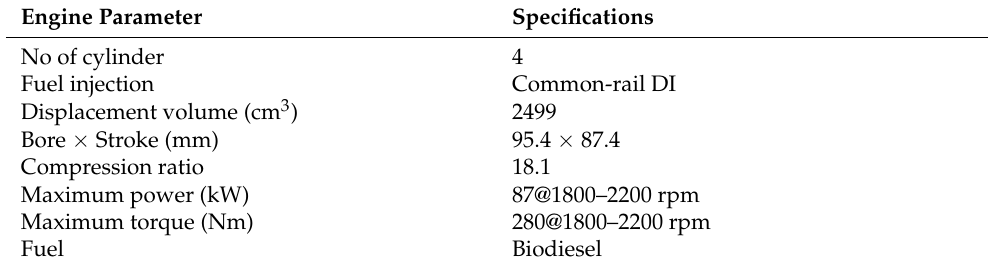
Figure 1. Schematic diagram of the experimental setup. Table 1. Engine specification of the 4JK-1TC model.